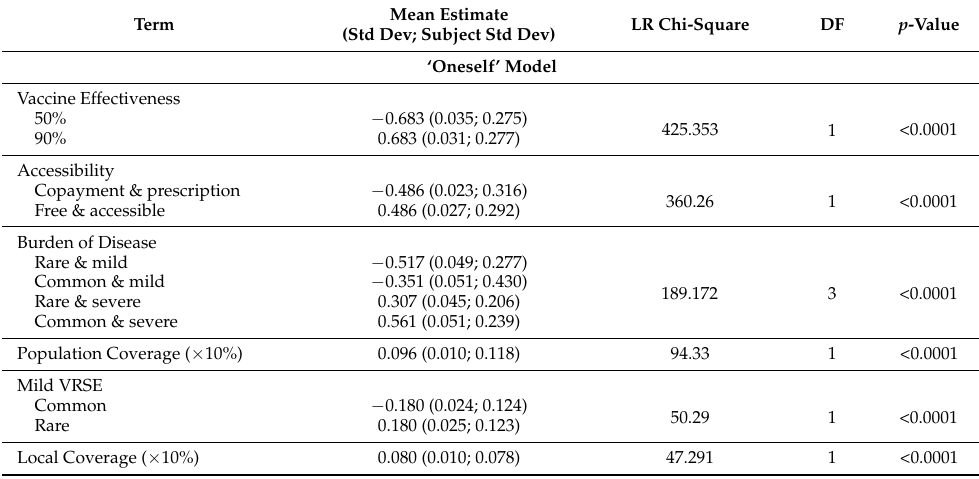
Table 4. Panel mixed logit model estimates (means and standard deviations) and significances of the attribute effects obtained from likelihood ratio (LR) tests. United